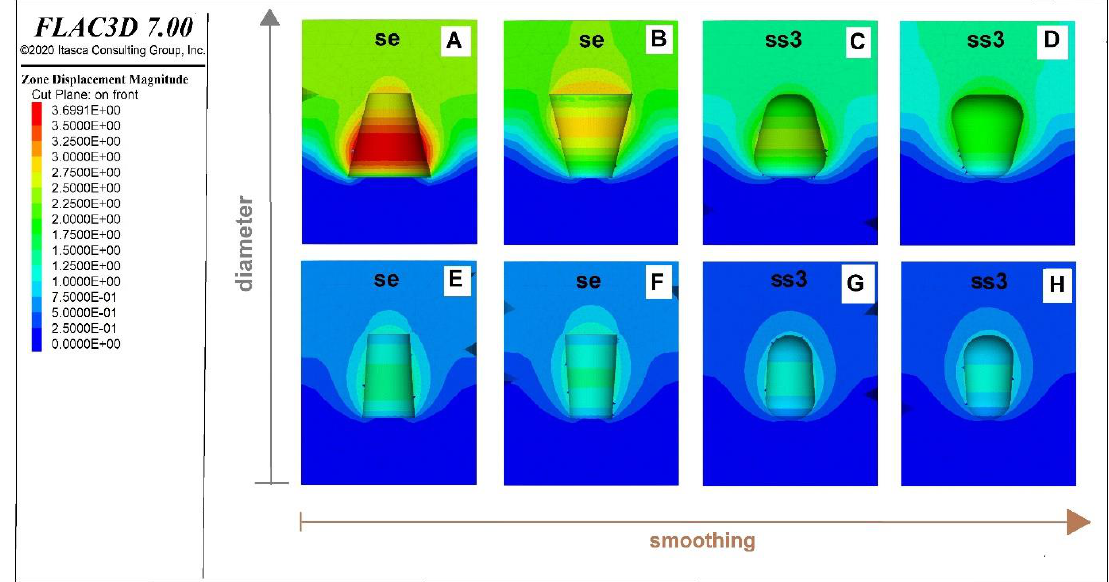
Figure 7. The displacement value and distribution in simulated caverns; the last withdrawal period: ( A – D ) caverns with a maximum initial diameter of 120 m, ( E – H ) caverns with a maximum initial diameter of 75 m. At the end of the last injection period, the tendency towards displacement distribu- tion related to the “smoothing” of sharp edges was similar to the first period. However, this tendency was more visible in the caverns with an enlarged top than in the caverns with an enlarged bottom (Figure 8). The value of the largest displacements was lower than in the withdrawal period. The largest displacements in the caverns with se and a maxi- mum initial diameter of 120 m (Figure 8A,B) reached 359.86 cm (enlarged bottom) and 350.00 cm (enlarged top). In the caverns with se and a maximum initial diameter of 75 m, the value of the displacements ranged from 125.0 to 175.0 cm (Figure 8 E,F). The smooth- ing to ss3 caused a decrease of the displacement value to 75.0–125.0 cm and a major change in their distribution (Figure 8C,D,G,H). Figure 8. The displacement value and distribution in simulated caverns; the last injection period: ( A – D ) maximum initial diameter of 120 m, ( E – H ) maximum initial diameter of 75 m.